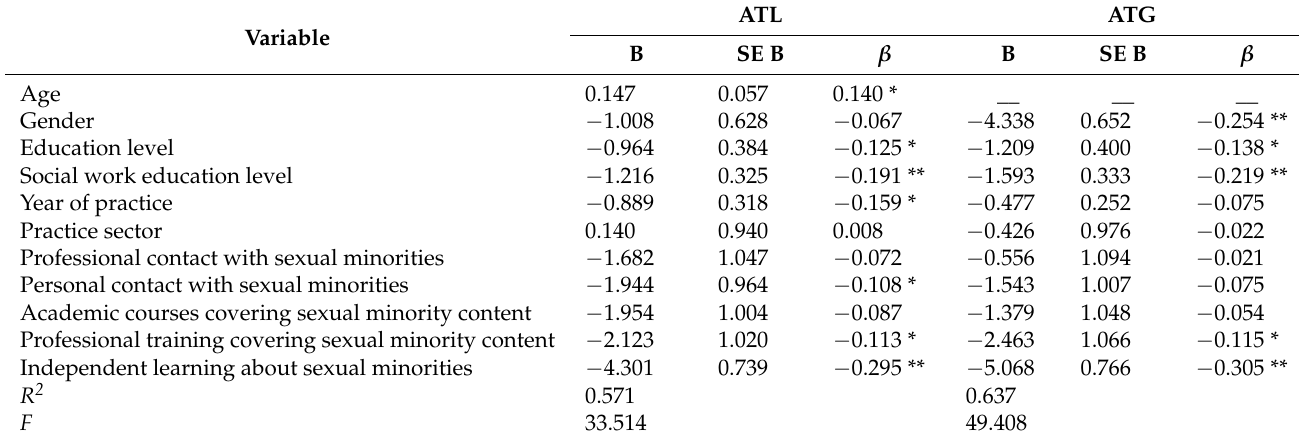
Table 3. Results of the Multiple Regression ( n =